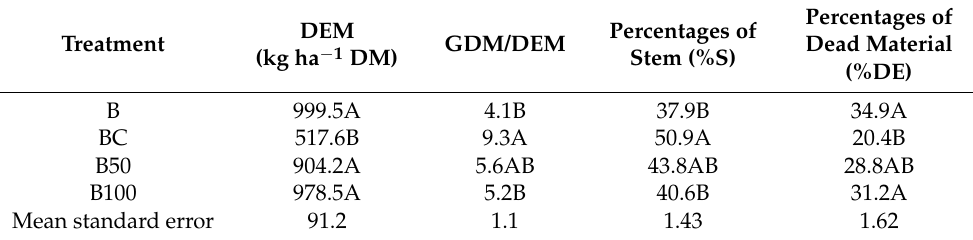
Table 4. Averages of dead dry mass (DEM), the green dry mass/dead dry mass ratio (GDM/DEM), and percentages of stem (%S) and dead material (%DE) for the different treatments at the end of the deferral.